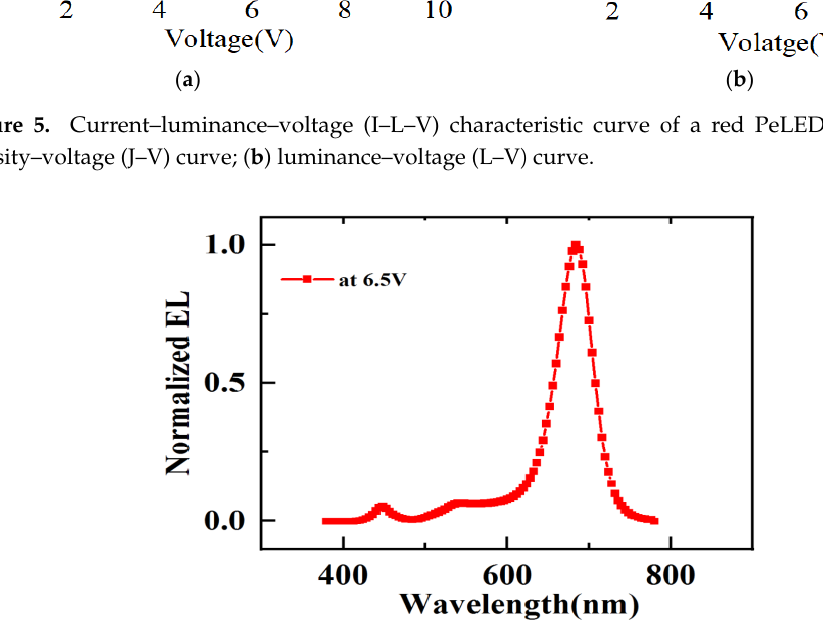
Figure 6. Electroluminescence spectra of a red PeLED .